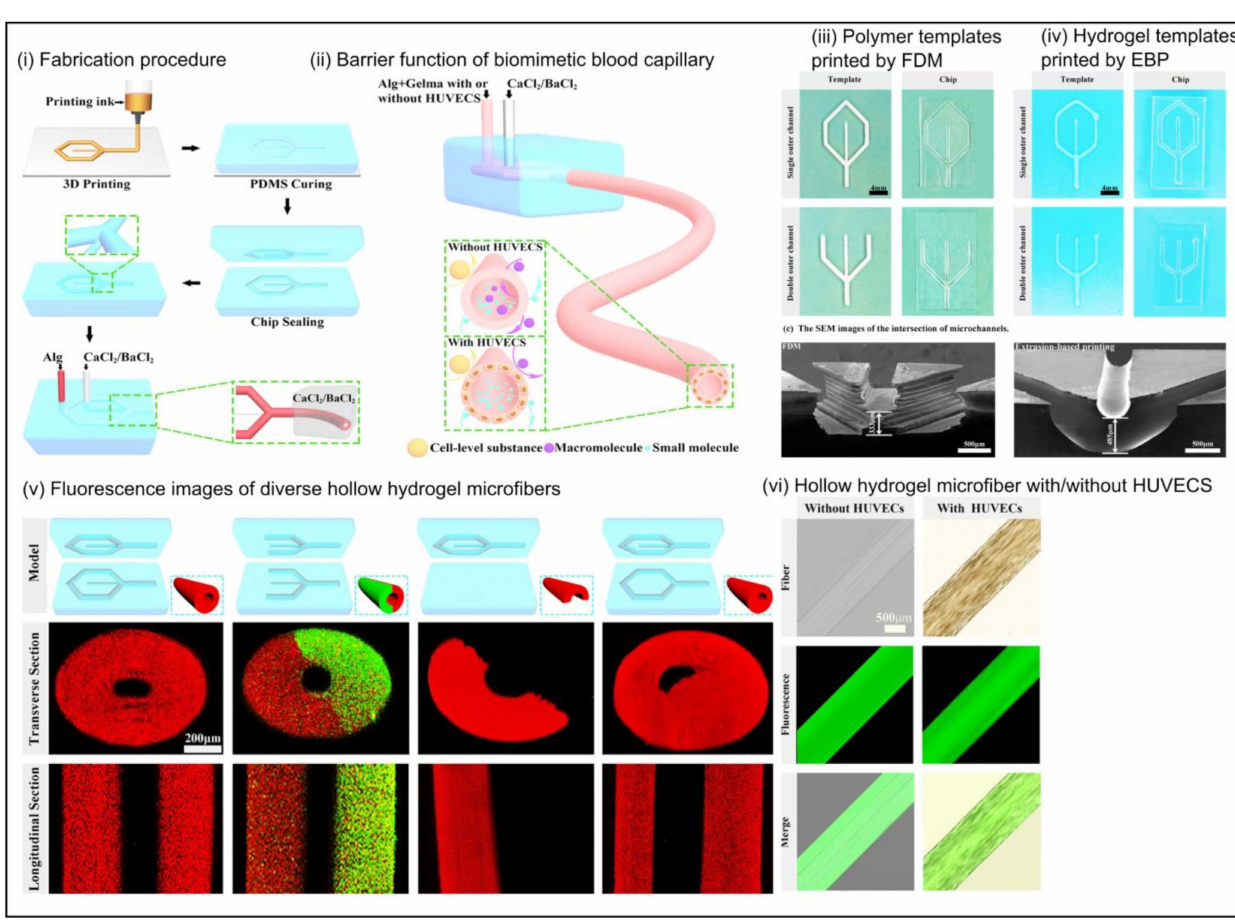
Figure 7. Fabrication of microfluidic chip to generate an in vitro model to simulate hollow biomimetic capillary using 3D bioprinting and hydrogel. ( i ) fabrication of templates and microfluidic